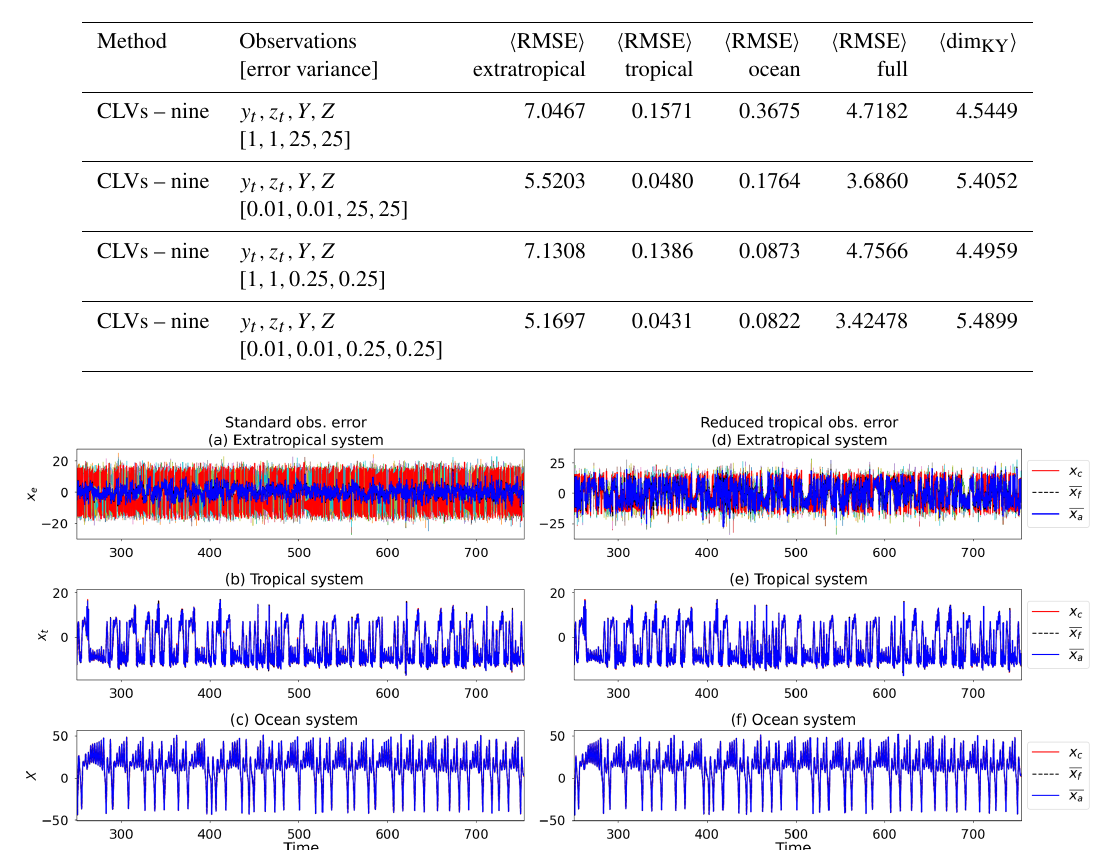
Table 4. Summary metrics of DA experiments using right-transform matrix (15) and ENSO observations ( y t ,z t ,Y,Z ). Parameters: assimi- lation window 0.08, inflation factor 1%, 10 ensemble members.